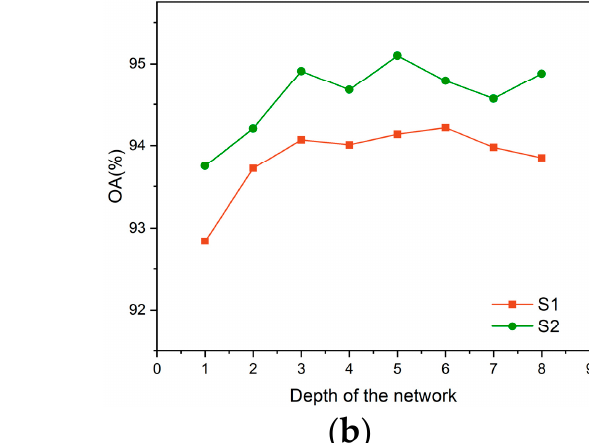
Figure 5. The performance of the RPNet with different numbers of ( a ) principal components and ( b ) depths.